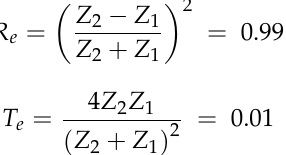
30 Np/m or 258 dB/m.